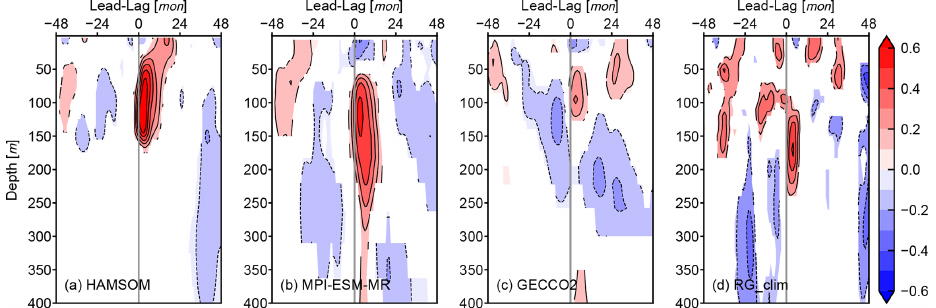
Figure 9. Lead–lag Pearson correlation coefficient between the DMI and salinity anomalies of the BoB at different depths from HAM- SOM (a) , MPI-ESM-MR (b) , GECCO2 (c) , and RG_Clim (d) , respectively. The contour intervals are 0.1. The analysis period is from 1960 to 2005 for (a) , from 1951 to 2005 for (b) and (c) , and from 2004 to 2018 for (d) , respectively. Only significant correlation coefficients with p value < 0 . 05 are